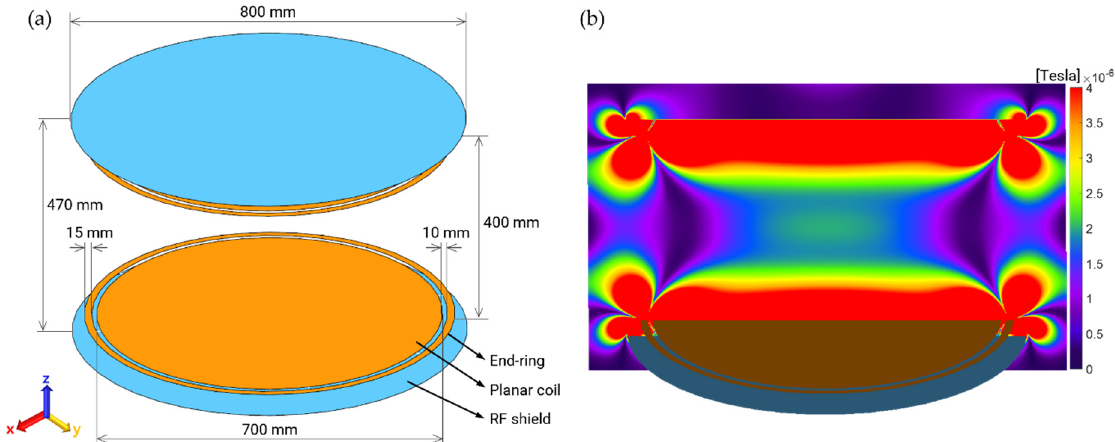
Figure 2. ( a ) Numerical modeling of the planar T X RF coil. The electromagnetic field generating the MR imaging signal forms in between two plana coil elements; ( b ) Excitation magnetic field (B 1+ ). The applied RF power was scaled to create 2 μ T of B 1+ at the center of magnet (upper elements of Tx RF coil were removed for better visualization).